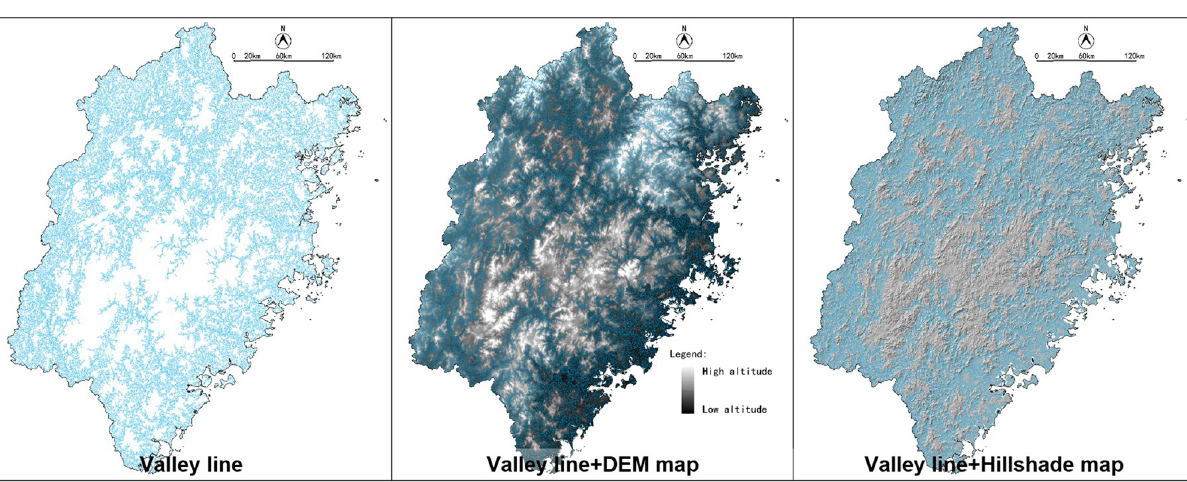
Figure 7. Valley line map of Fujian Province created by ArcGIS